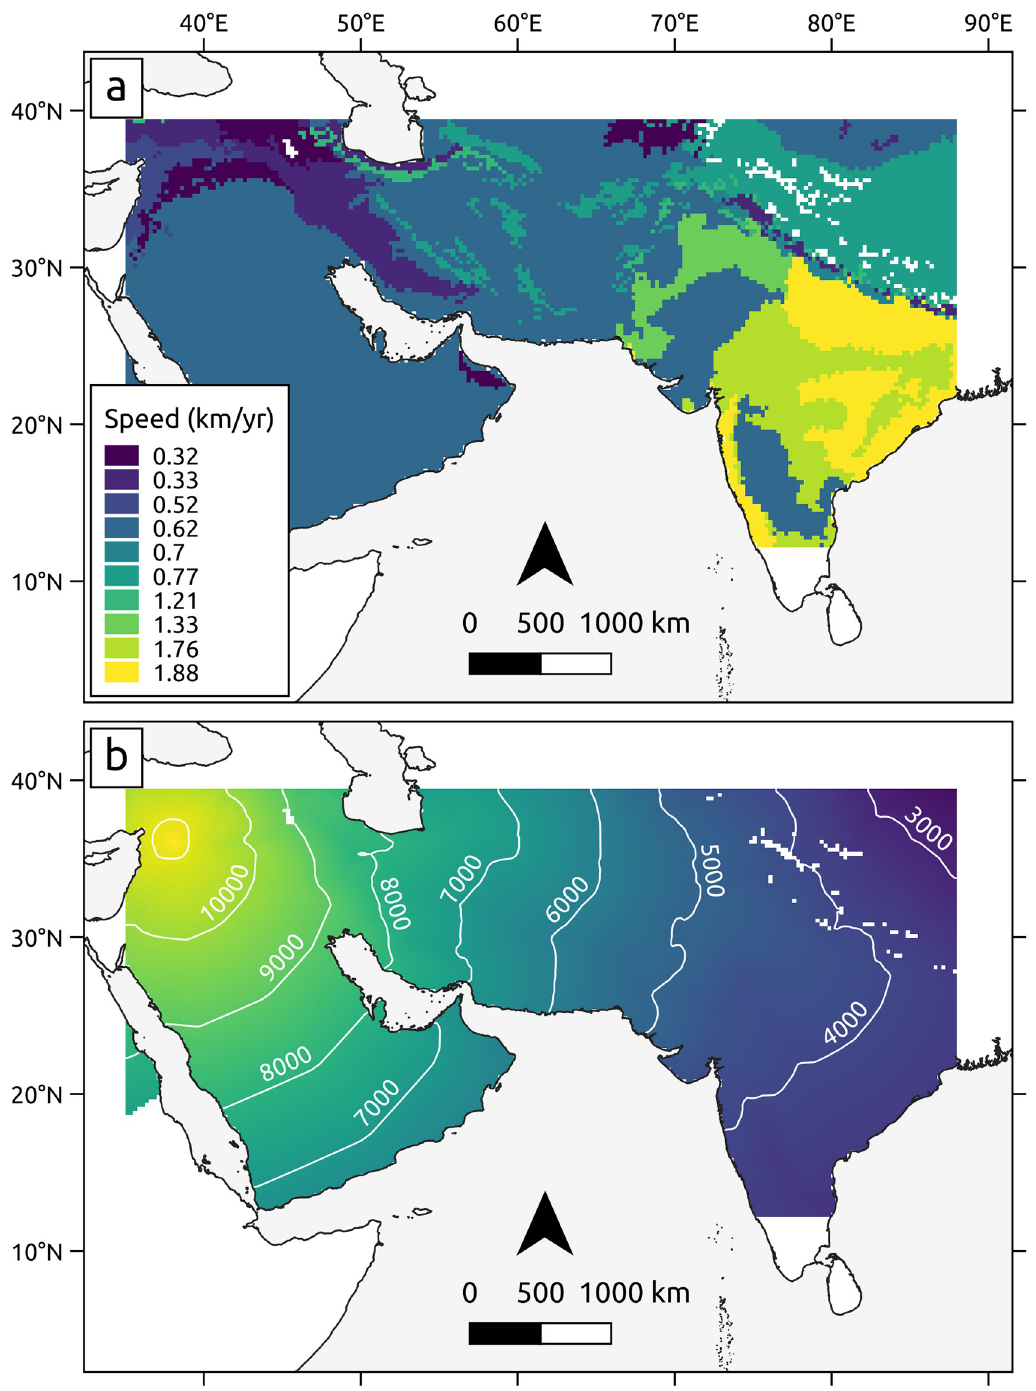
Fig 4. a) Simulated speeds of advance for each terrestrial ecoregion according to the optimal parameter set. b) Simulated arrival times with contour lines (yr BP) shown every 1000 years.